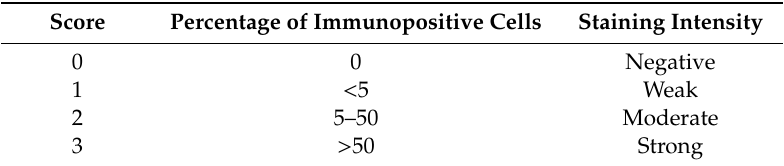
Table 1. Immunoreactive score for cytokines